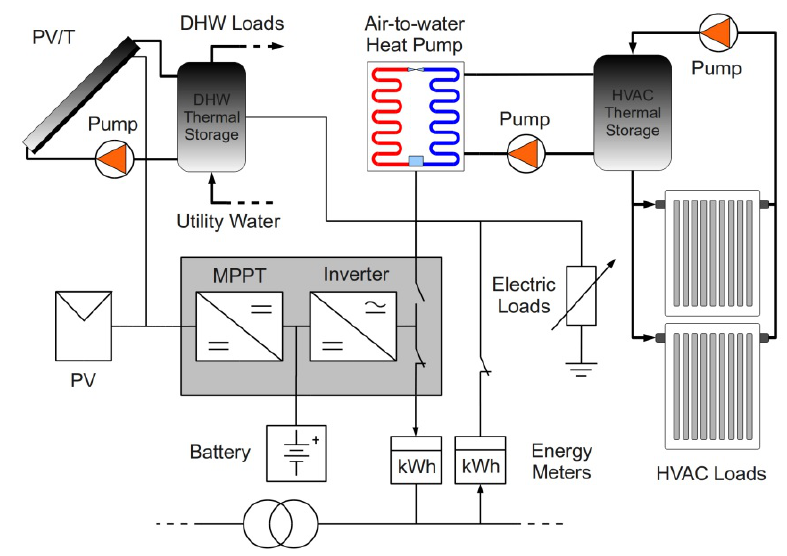
Figure 13. Schematic diagram of PV/T tri-generation system setup